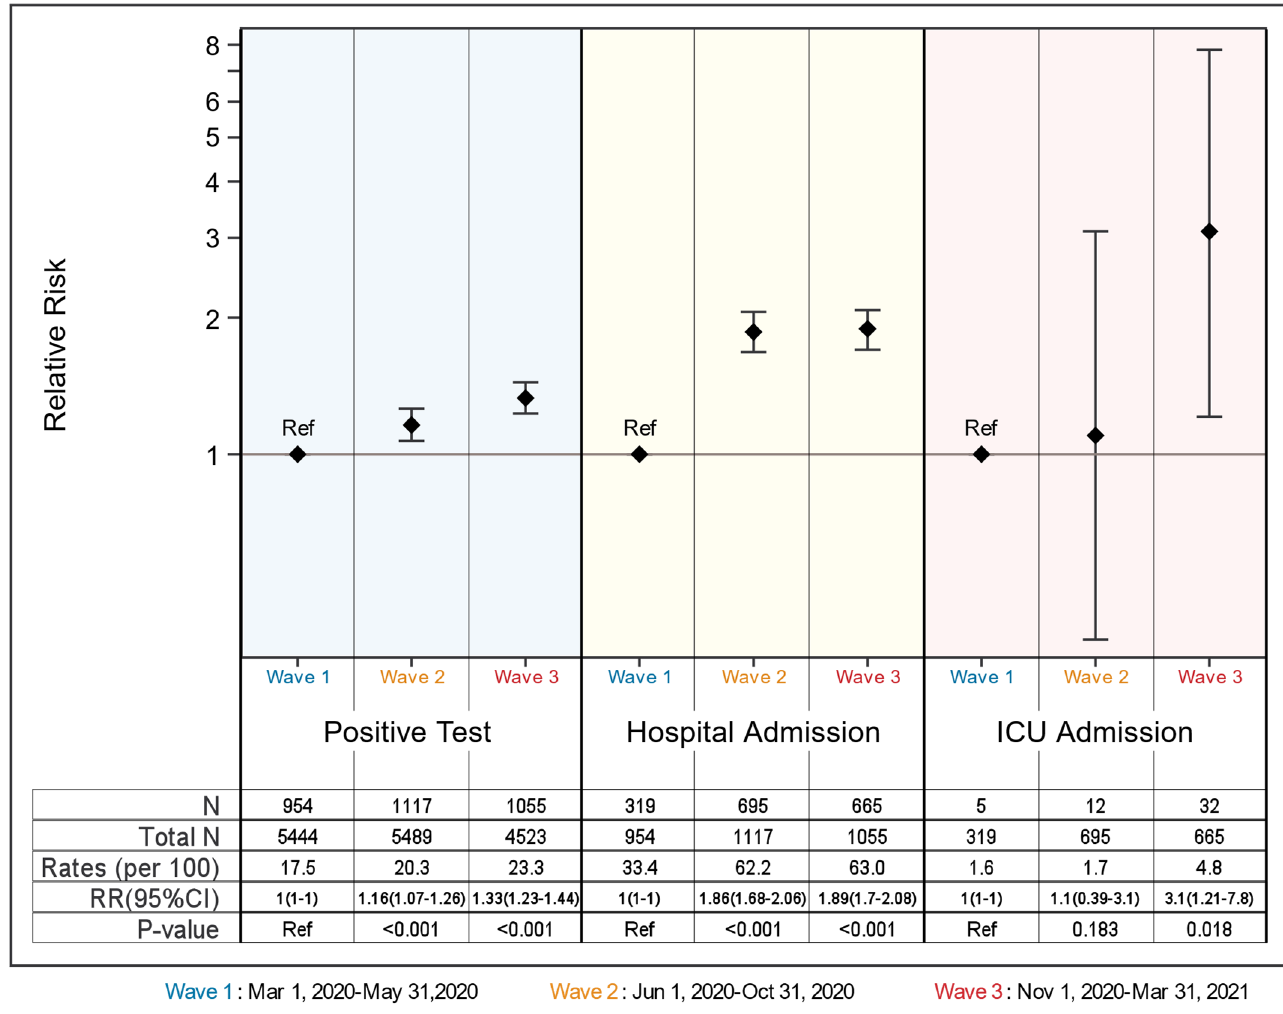
Figure 2. The relative risk of Wave 1 versus Wave 2 and Wave 3 by positive COVID-19 tests results, hospital admission, and ICU admission.